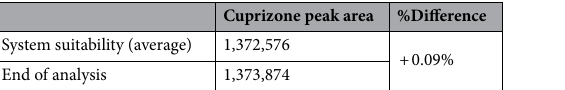
Table 8. Autosampler stability for validation.